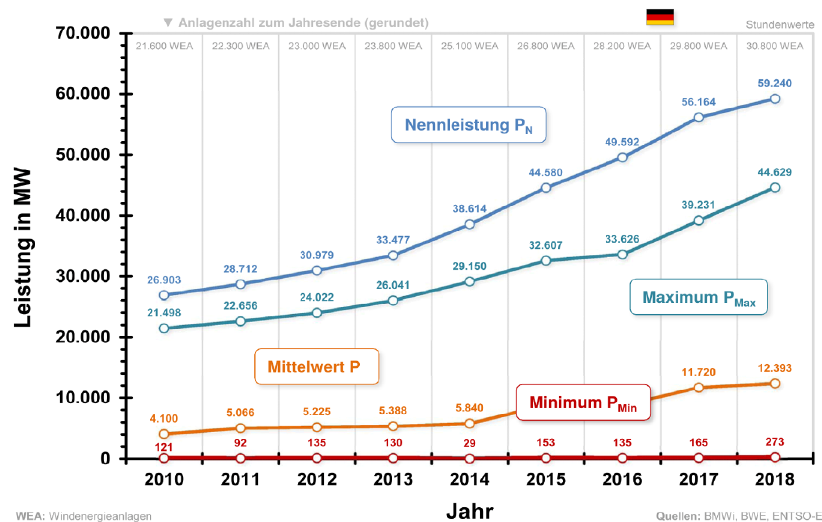
Fig. 3. – Development of wind energy in Germany since 2010. Power in MW plotted against the corresponding year. Top curve denotes nominal capacity (“Nennleistung”), second from top is maximum power generation (“Maxmimum”), “Mittelwert” is the average power generation and bottom curve denotes the minimum power gernation. Figure reprinted with friendly permission from